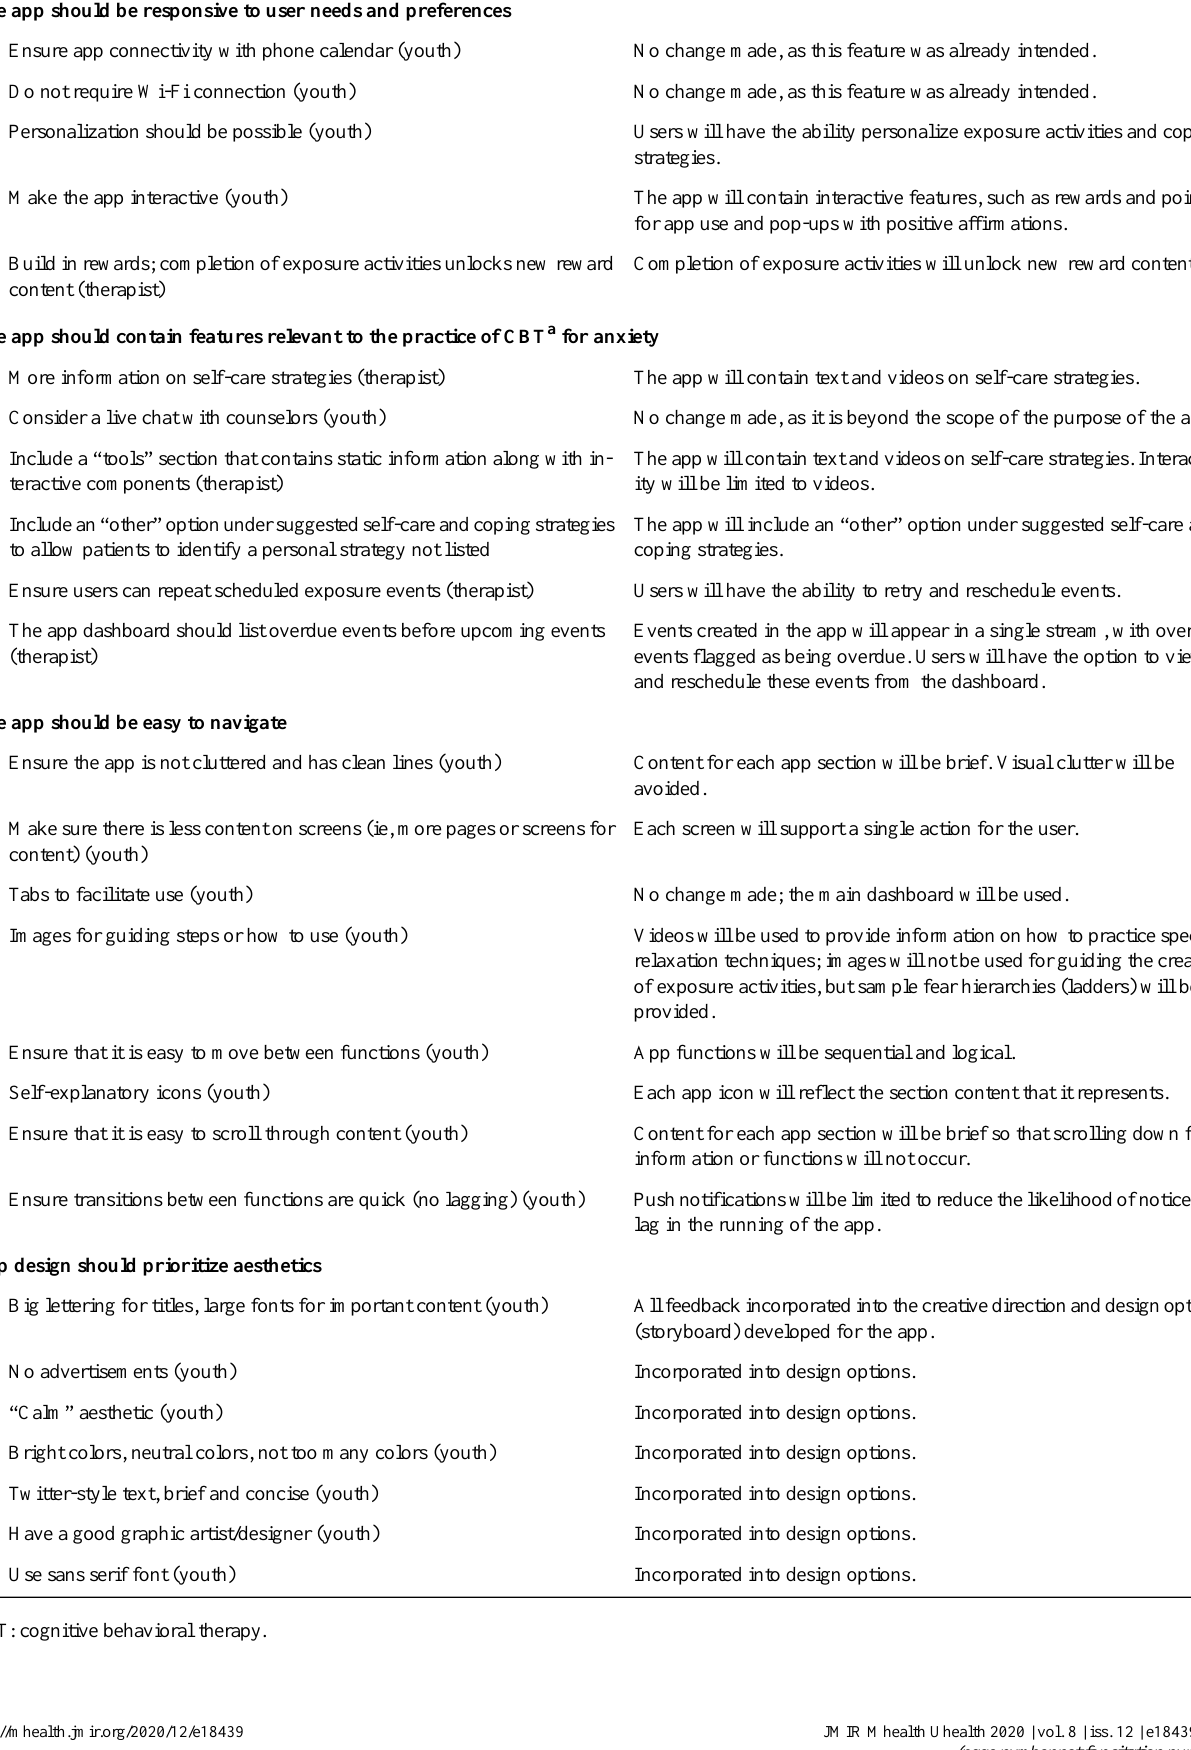
Impact on MindClimb development and designDevelopment area and